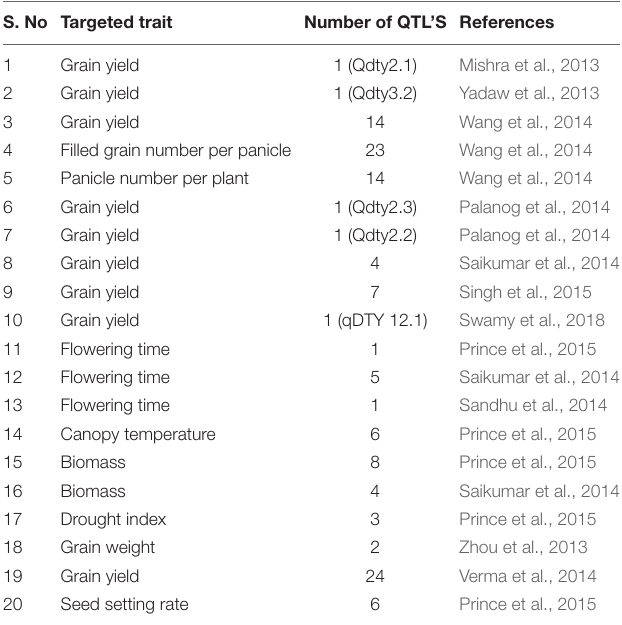
TABLE 2 | QTLs identified for drought tolerance related traits in